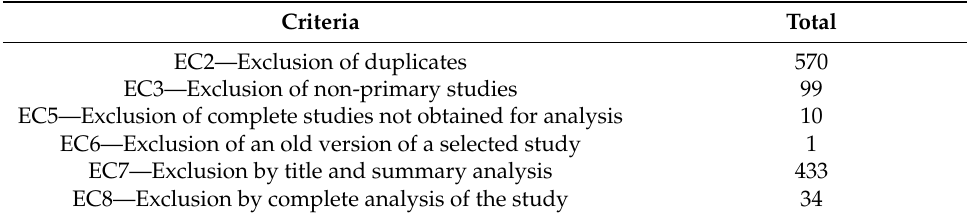
Table 2. Total by exclusion criteria.